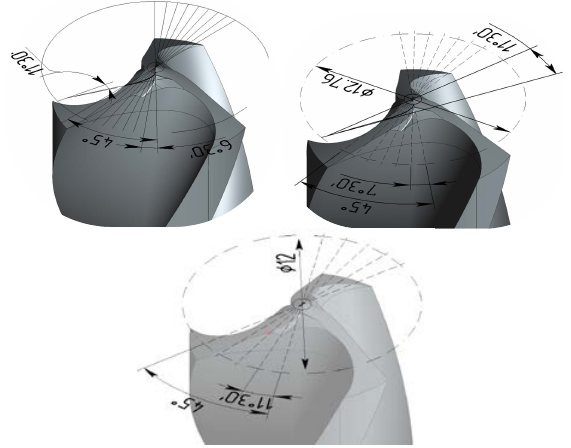
Fig. 2. Areas of the gash with the 9th, 7th and 5th reference points